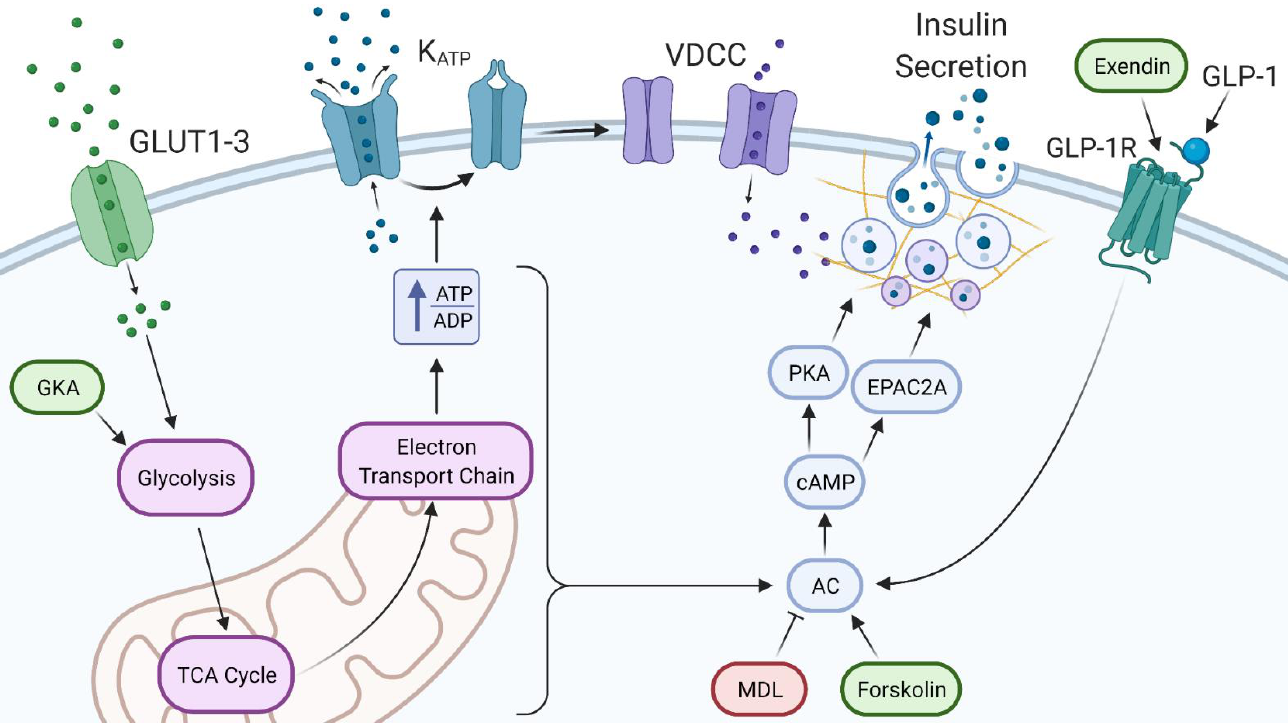
Figure 6. The triggering and amplifying pathways of insulin secretion in extreme glucose. (Left) Glucose enters the beta cell and is metabolized, causing an increase in the ATP to ADP ratio. ATP-sensitive potassium channels (KATP) close, causing membrane depolarization, the opening of voltage-dependent calcium channels (VDCC), and insulin secretion. (Right) GLP-1 from alpha cells or exendin stimulate beta-cell GLP-1 receptors which stimulate AC. Additionally, various metabolites produced from glucose metabolism can stimulate AC. Increased production of cAMP stimulates PKA and EPAC2A, causing increased insulin secretion by various mechanisms. Ovals indicate points of stimulation (green) or inhibition (red) for pharmacological agents used in these studies.